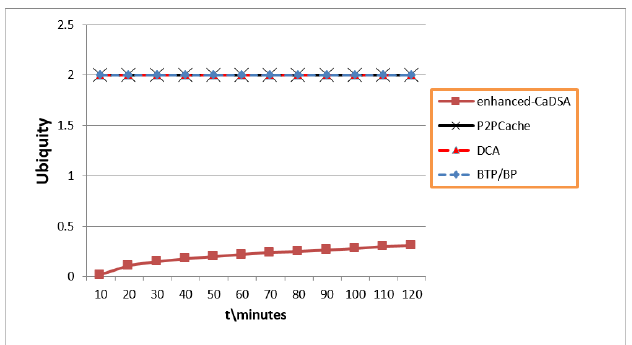
Figure 19. Privacy Factor (Ubiquity Metric).